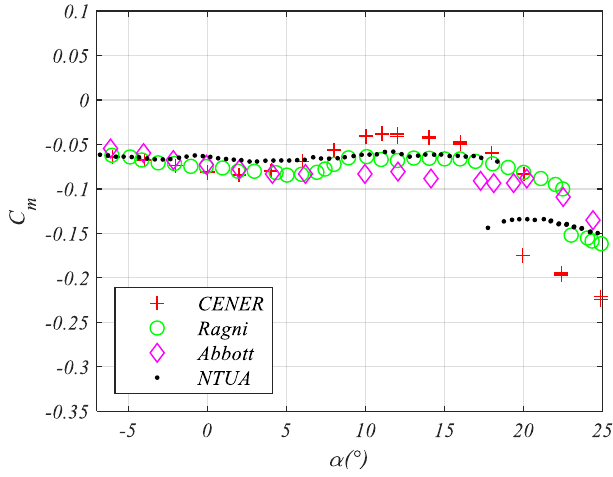
Figure 12. C m curves. Comparisons with experimental data from literature [22–24].